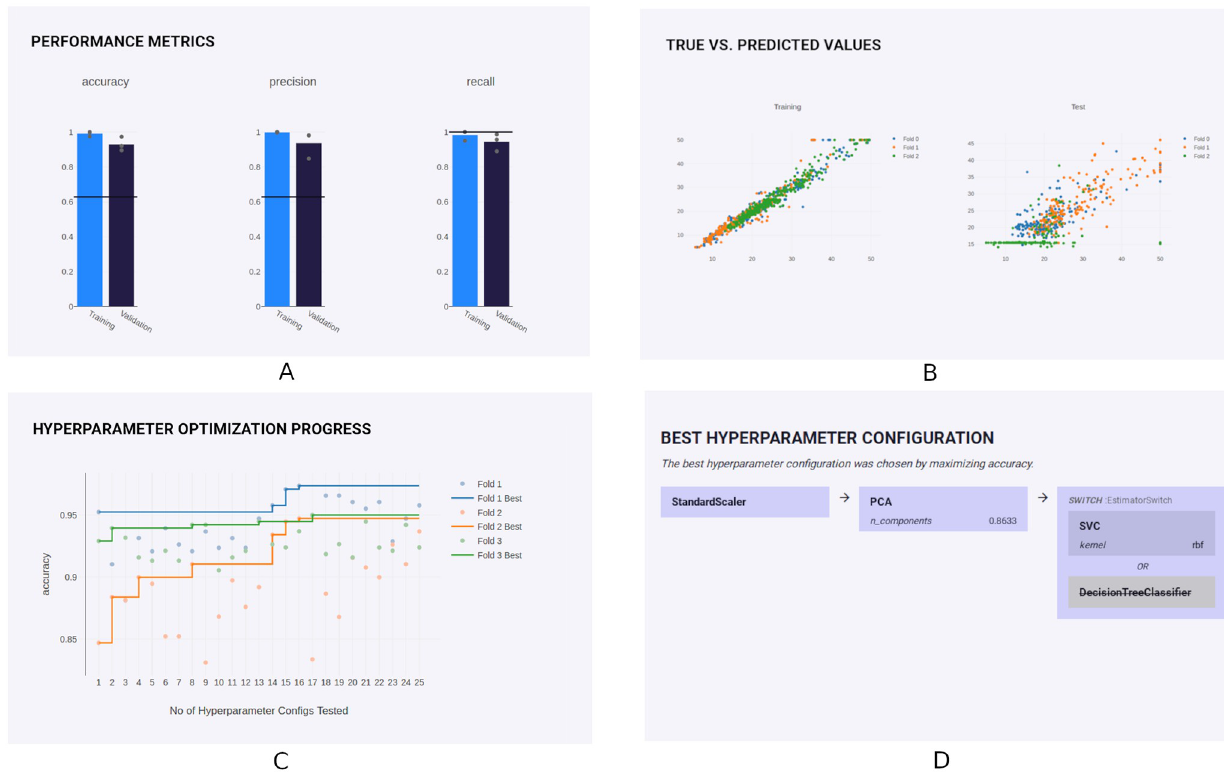
Fig 3. PHOTONAI explorer. Example plots of PHOTONAI’s result visualization tool called Explorer. A : User-defined performance metrics, here accuracy, precision and recall, for both training (blue) and test (dark) set. The horizontal line indicates a baseline performance stemming from a simple heuristic. B : For regression problems, true and predicted values are visualized in a scatter plot on both train (left) and test (right) set. The values are generated by the best model found in each outer folds, respectively. C : Hyperparameter optimization progress is depicted over time for each outer fold. D : Pipeline elements and their arrangement is visualized including the best hyperparameter value of each item.